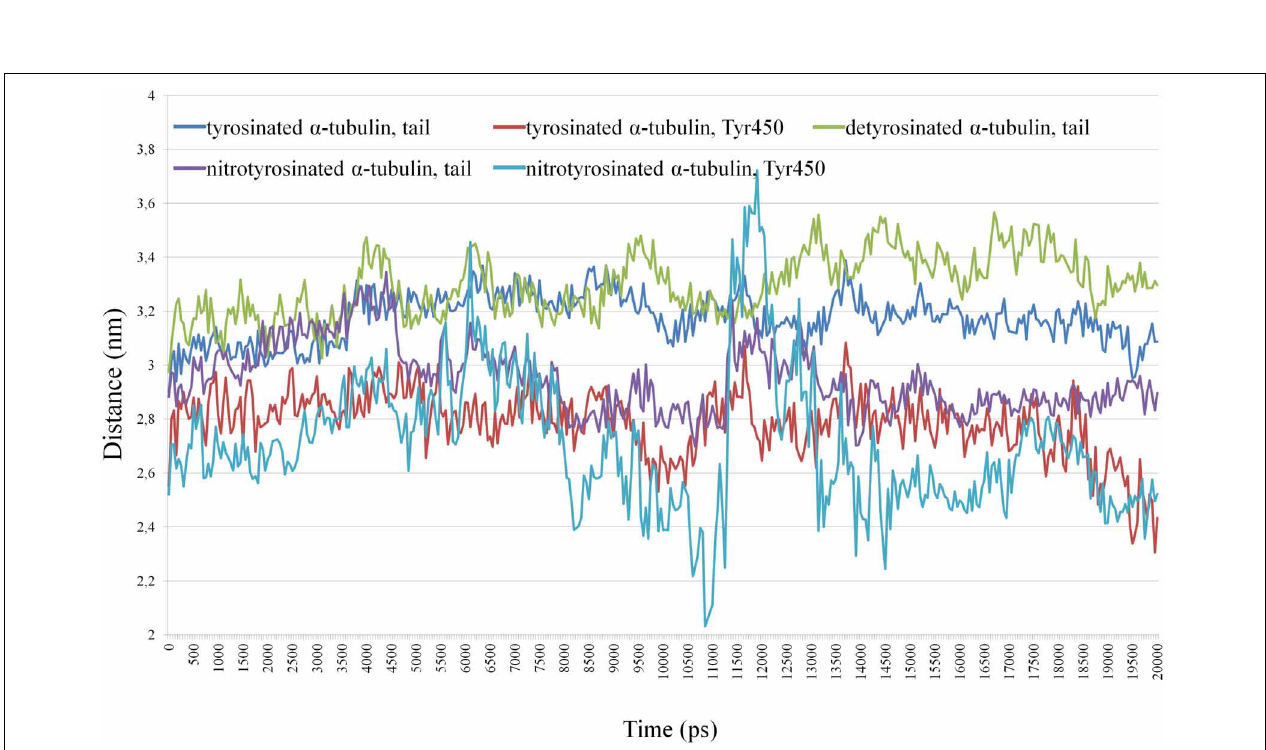
FIGURE 7 | Distance between the centers of masses of kinesin-8 and the C-terminal tails from last 15 (14) residues and non-modified and nitrated Tyr 450 α -tubulin.